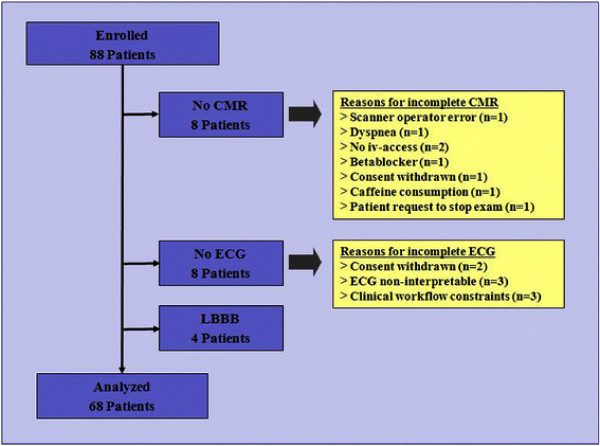
Outline of Patient Enrollment. CMR = Cardiovascular Magnetic Resonance, ECG = exercise electrocardiography, LBBB = left bundle-branch block.